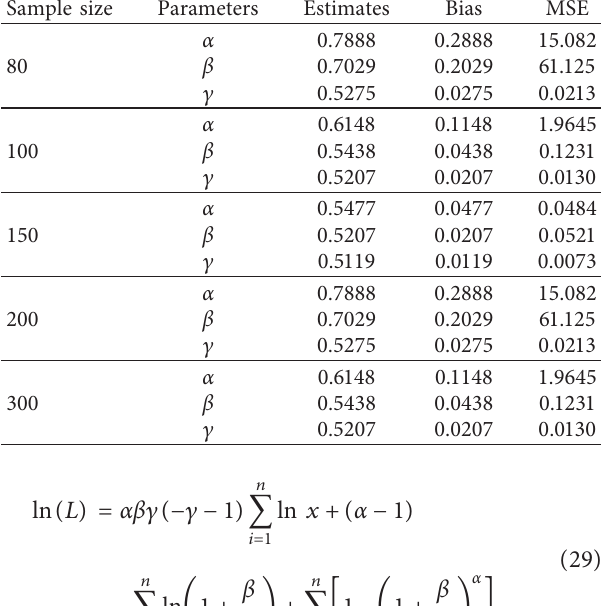
Table 2: Estimates of parameter, bias, and MSE at α � 0.5, β �